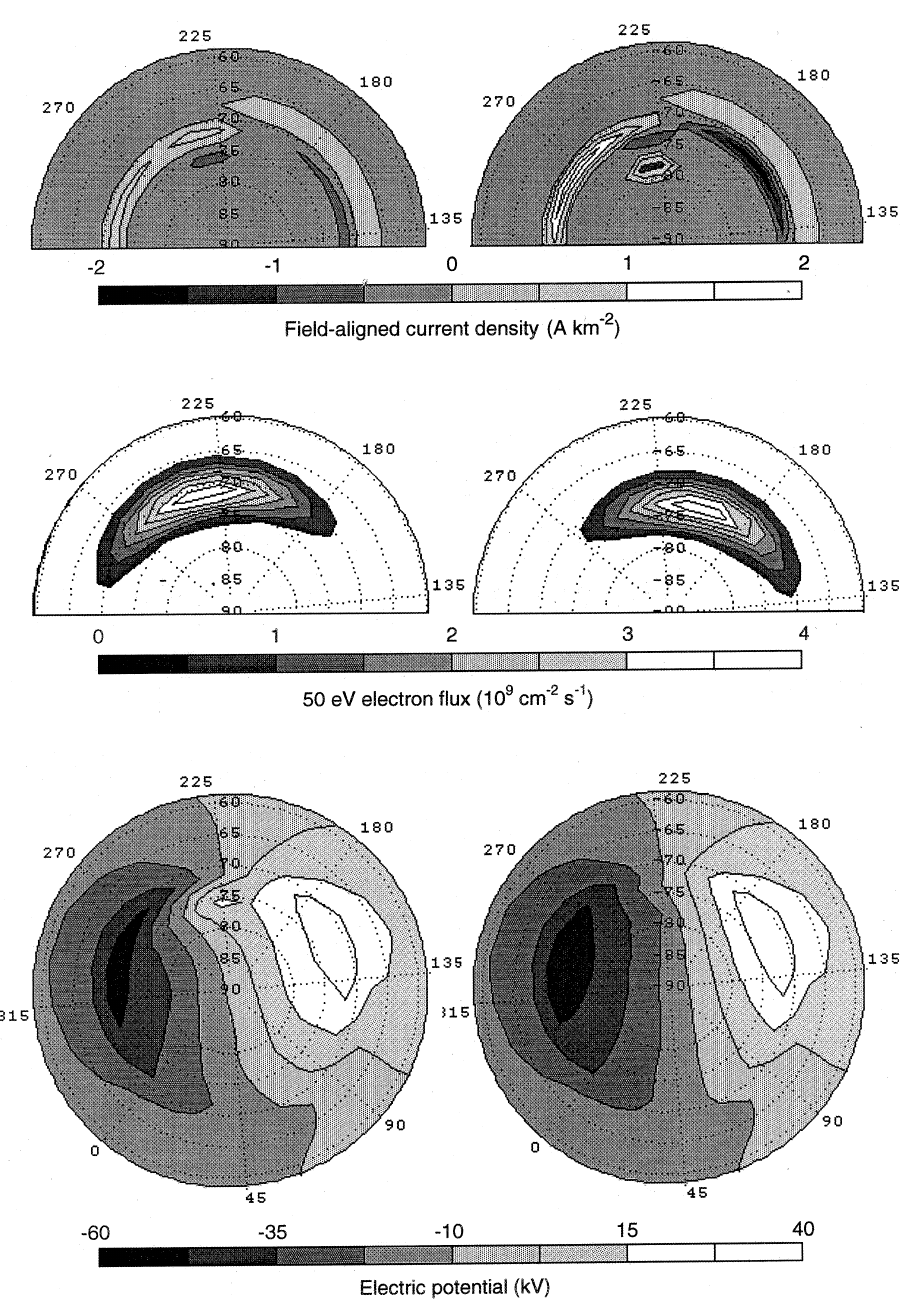
patterns of the ionospheric convection. The left plots correspond to the Northern (winter) Hemisphere, the right plots to the Southern (summer) Hemisphere. The Sun position is at the